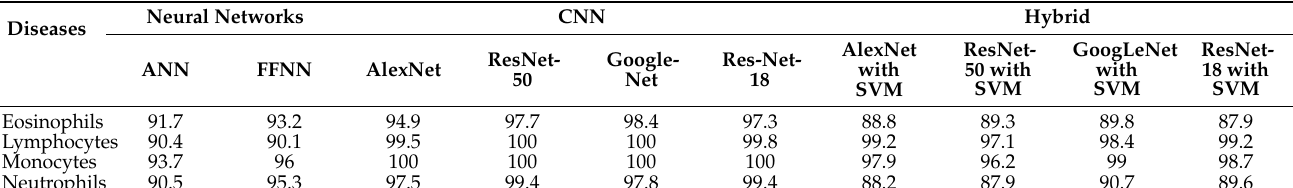
Table 6. The accuracy reached using all proposed systems in the diagnosis of each disease.